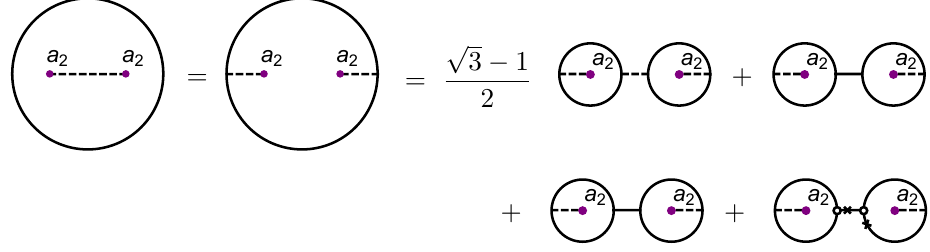
Figure 57 . The above diagrams are related by partial fusions (cid:12)rst between X and Y TDLs and then between two Y TDLs. Since we obtain a combination of products of lasso diagrams of a 2 , the r.h.s. vanish identically but the l.h.s. clearly does